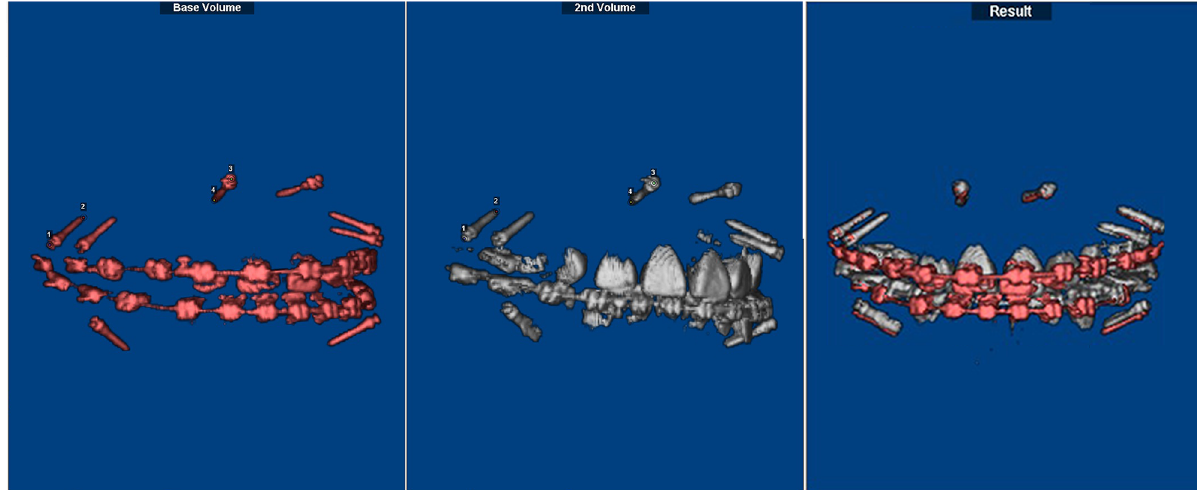
Fig 2. Implant superimposition for the adult sample. It was performed with the Dolphin software using the registration of four points: both endpoints of the two unloaded implants on the same